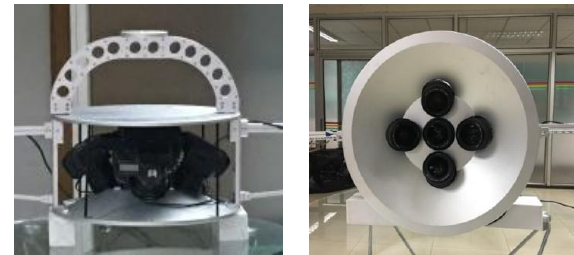
Figure 2. The wide-angle